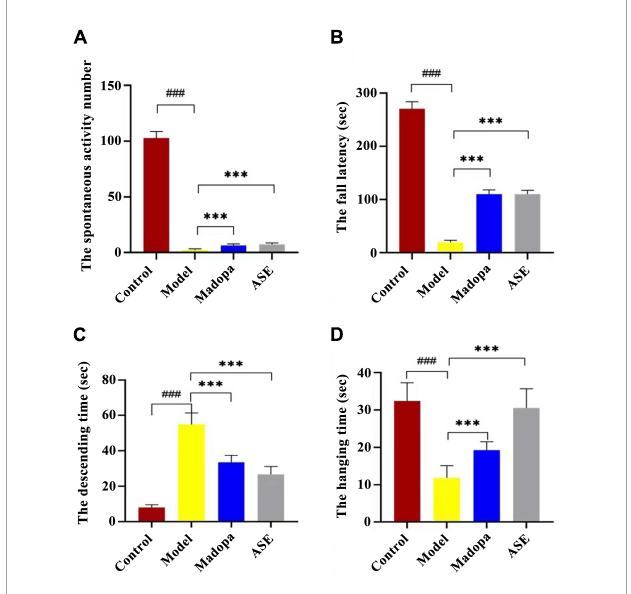
FIGURE2 ASE treatment alleviates motor deficits in MPTP-induced Parkinson’s disease mice. (A) the spontaneous activity test; (B) the rotarod test; (C) the pole-climbing test; (D) the hanging test. The data are presented as the means ± SDs of 15 biological replicates (### p < 0.01, compared with the control group; ∗∗∗ p < 0.05, compared with the model group).